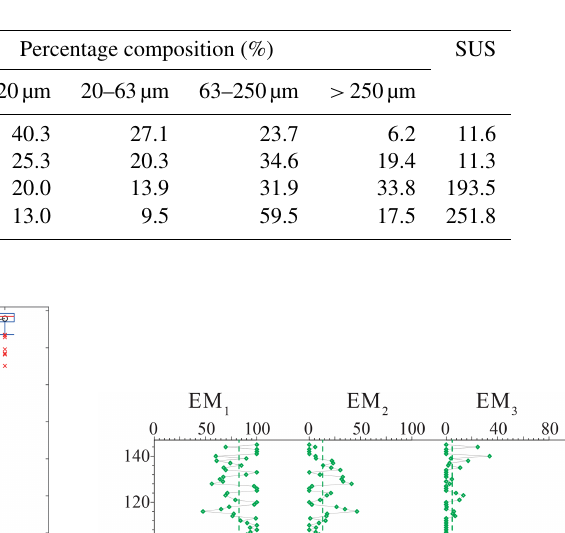
Figure 3. Variation of grain-size components and river sediment parameters from the upper Min River. The dotted lines represent the average value of the whole sequence. Table 1. Statistics for grain-size fractions in the upper Min River.